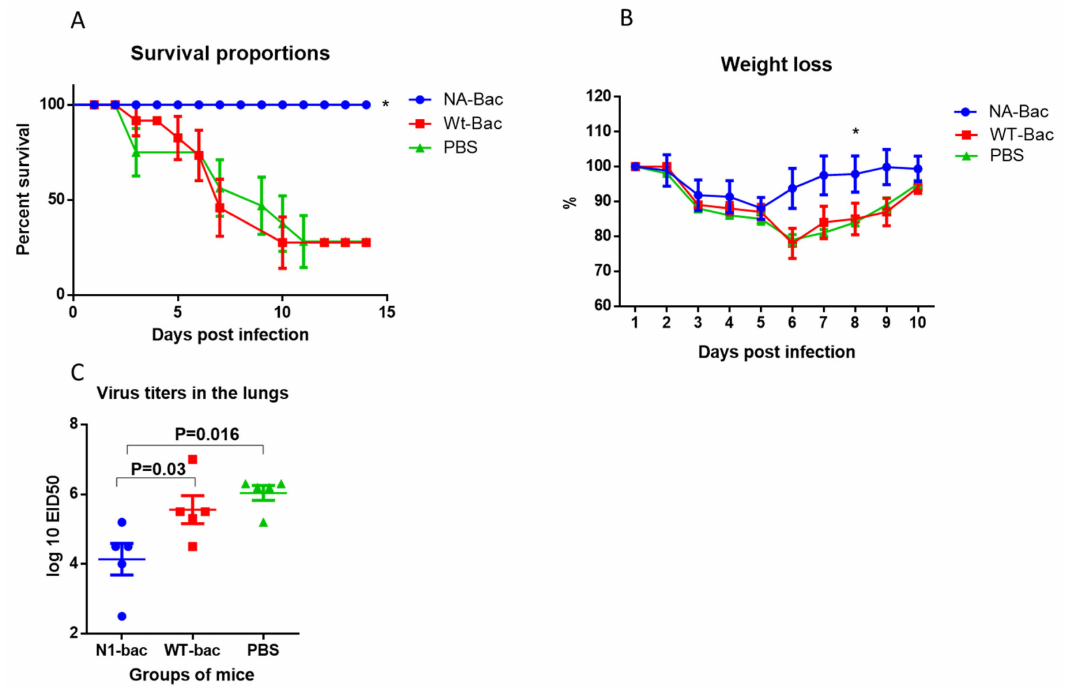
Figure 7. Protection after immunization with NA-bac against infection with a drift variant of the A/H1N1 pdm09 influenza virus, A/South Africa/3626/13 (H1N1)pdm09. Data from one of two independent experiments is presented. ( A ) Mortality analysis (n = 10). Log-rank (Mantel-Cox) test, * — p < 0.05. ( B ) Dynamics of weight, % (n = 10). * — p < 0.05. ( C ) Infectious virus isolation from the lungs (n = 5). Each dot represents an individual lung titer (EID 50 /0.1 mL). The dashes represent the mean and standard